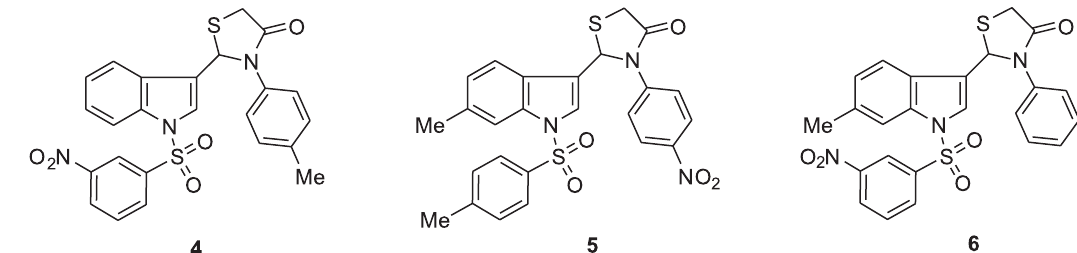
FIGURE 3 - Chemical structure of 2-( N - m -nitrophenylsulfonylindol-3-yl)-3- p -methylphenyl-1,3-thiazolidin-4-ones ( 4 ), 2-( N - p - methylphenylsulfonyl-6-methylindol-3-yl)-3- p -nitrophenyl-1,3-thiazolidin-4-ones ( 5 ) and 2-( N - m -nitrophenylsulfonyl-6- methylindol-3-yl)-3-phenyl-1,3-thiazolidin-4-ones ( 6